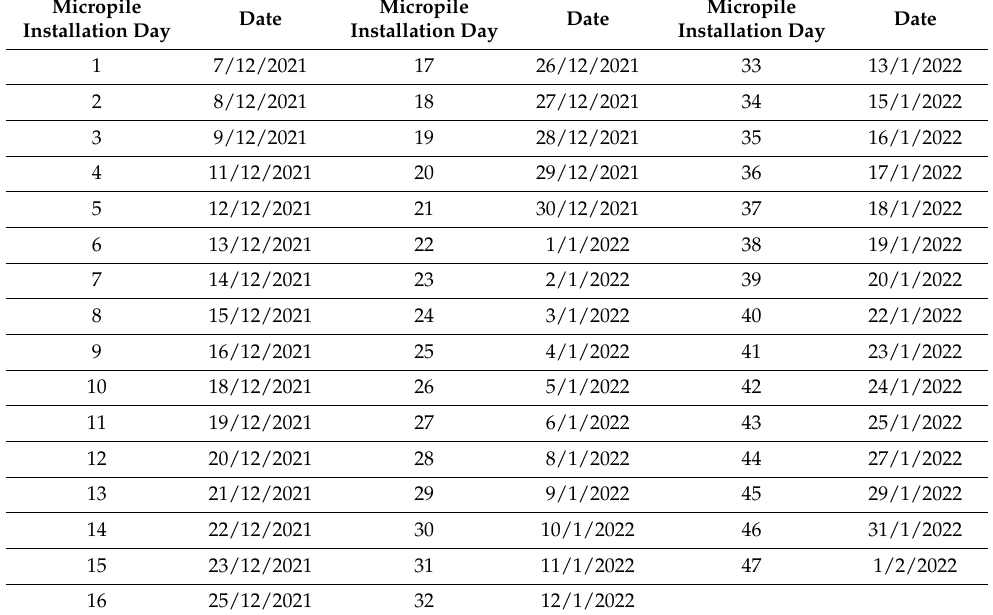
Table 1. Dates of micropile installation.